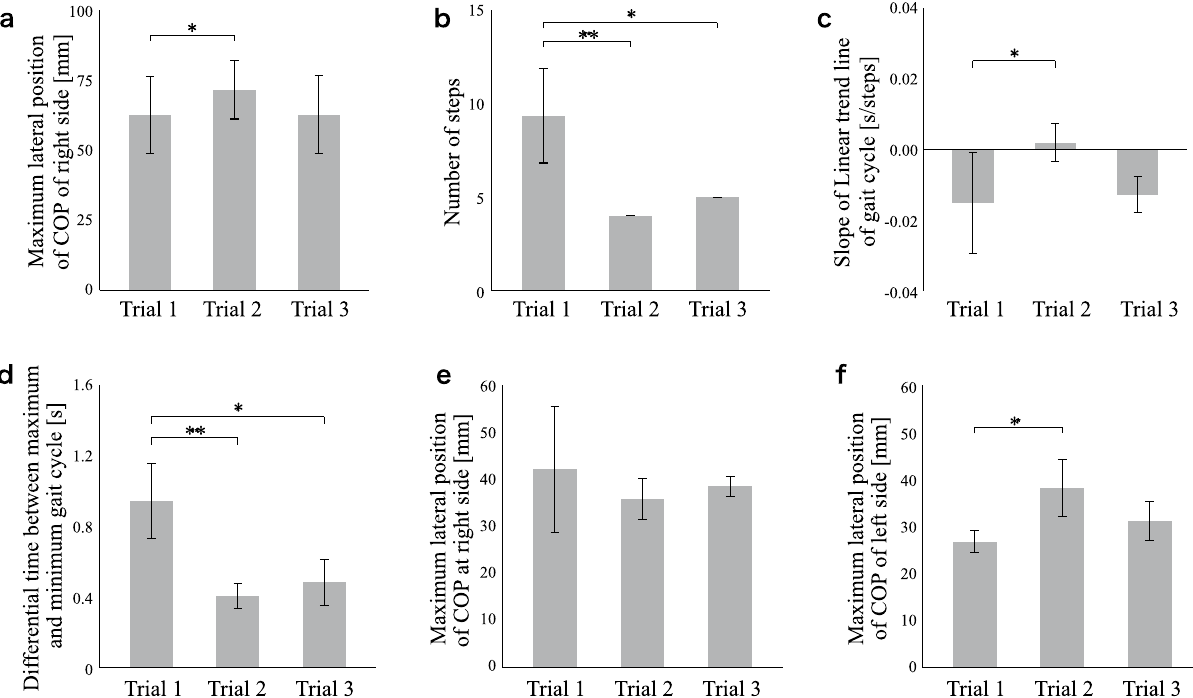
Figure 3. Experimental results for each participant. Each experiment consisted of preintervention without HAL (Trial 1), intervention with HAL (Trial 2), and postintervention without HAL (Trial 3). The bar graphs indicate the average of each index, and error bars indicate the standard deviation of the value. **P < 0.01, *P < 0.05; absence of an asterisk indicates P > 0.05. ( a ) The maximum lateral position of the COP on the right side in the slalom area for Case 1. ( b ) Number of steps in the turning area for Case 2. ( c ) Slope of the linear trendline of the gait cycle in the out and back areas for Case 3. ( d ) Time difference between the maximum and minimum gait cycles in the out, turn, and back areas for Case 4. ( e ) Maximum lateral position of the COP on the right side in the straight area for Case 5. ( f ) The maximum lateral position of the COP on the left side in the straight area for Case 5. COP center of pressure; HAL hybrid assistive limb.